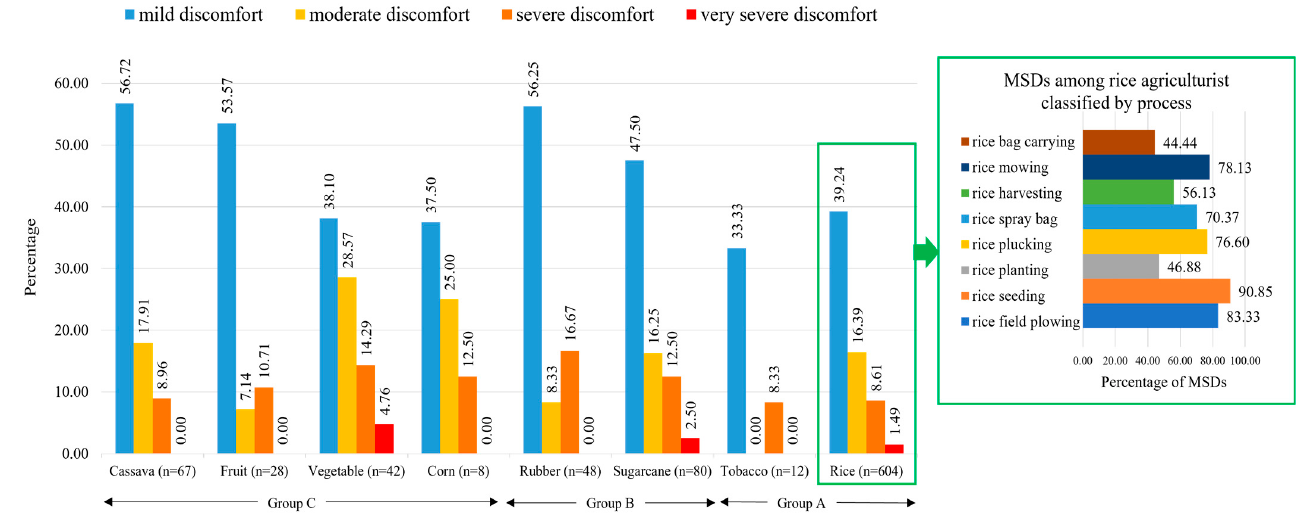
Figure 4. Musculoskeletal discomfort levels classified according to group and cultivating type.